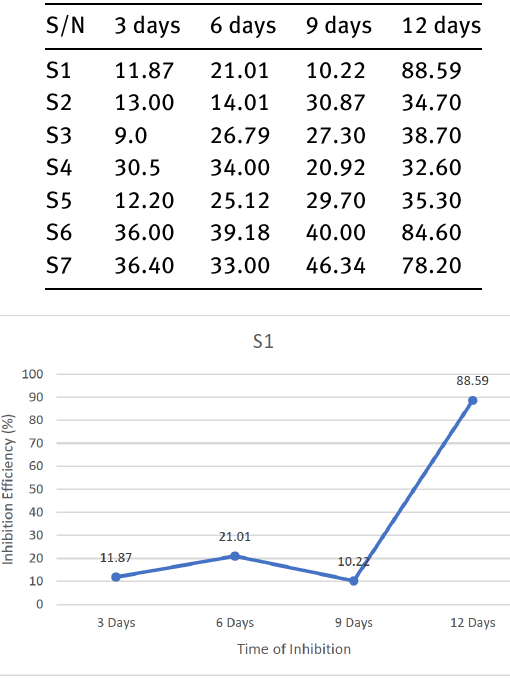
Figure 1: Plot of S1 (Inhibition eflciency versus Time of inhibition (days).